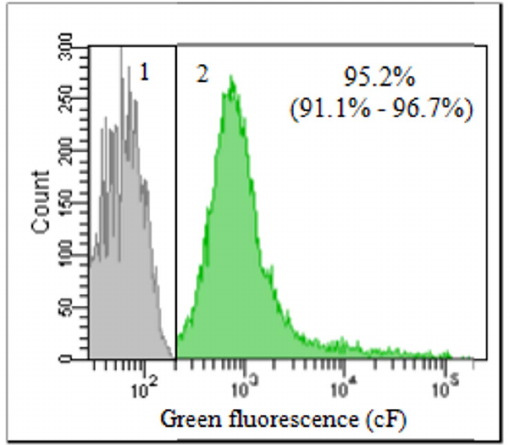
Figure 7. Overlay diagram of the flow cytometric histograms representing metabolically active and inactive E. coli subpopu- lations. Inactive (cF 2 ) (1) and active (cF + ) (2) ETEC population are determined by cFDA staining. Inactive cells do not stain because they either lack the enzyme activity to metabolize cFDA to cF and/or cF diffuses freely through the membrane, while metabolically active cells are green fluorescent (cF + ). Both populations are separated by the black line. The overall mean of triplicates and range are provided.